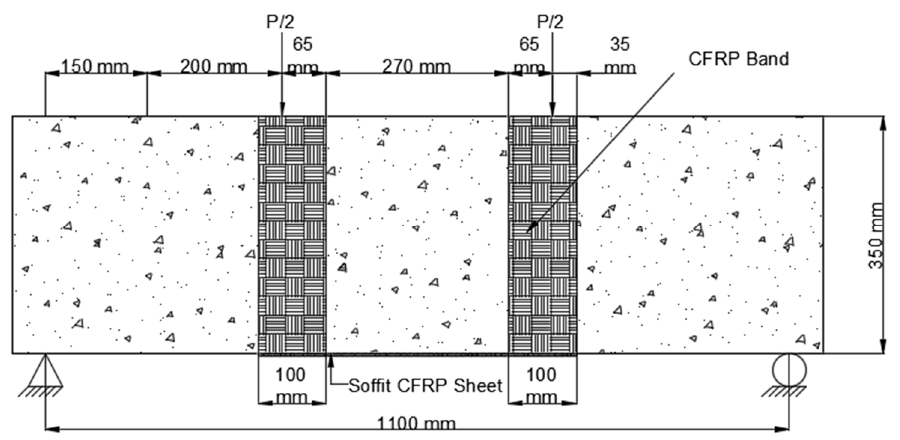
Figure 12. Placement of CFRP on beam Scheme 5 (B5).